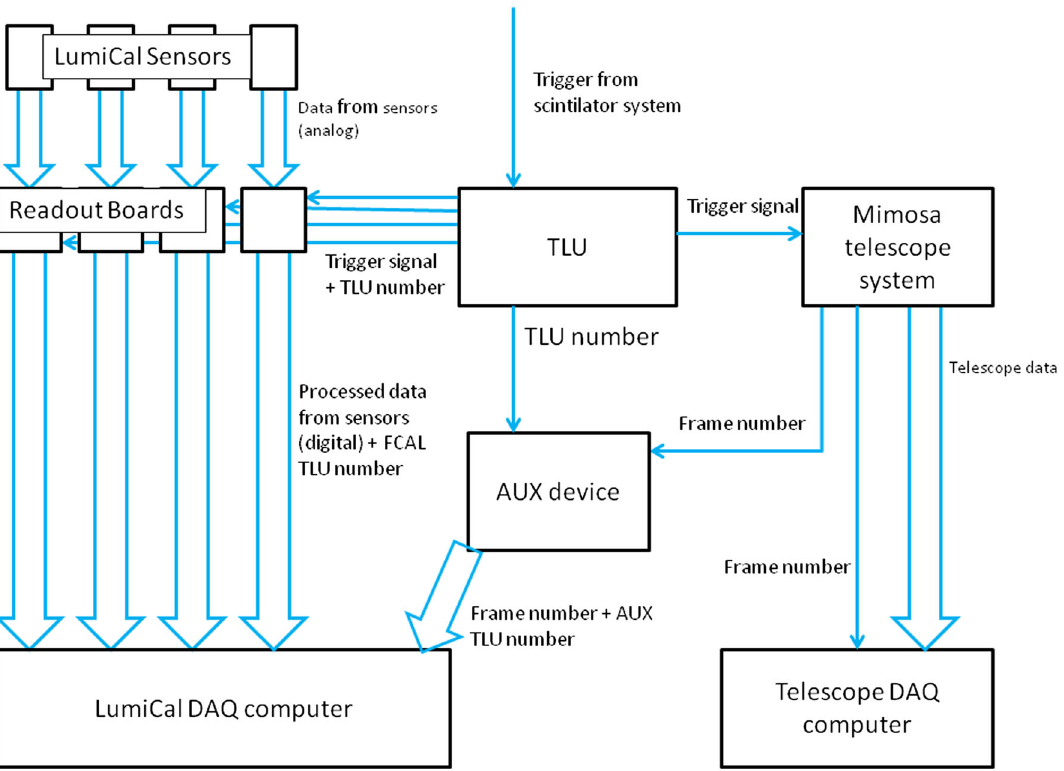
Fig. 9 A schematic of the connections and the path of the signals in the system. Data is symbolized by a thick arrow, while simple bit information (e.g. the trigger signal) is symbolized by a thin